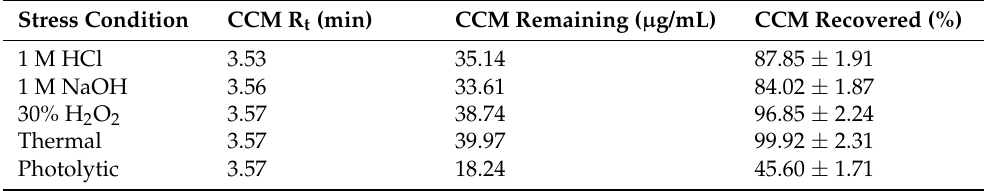
Table 8. Results of forced-degradation studies of CCM at 40 µ g/mL concentration under various stress tests for the greener HPLC assay (mean ± SD; n =